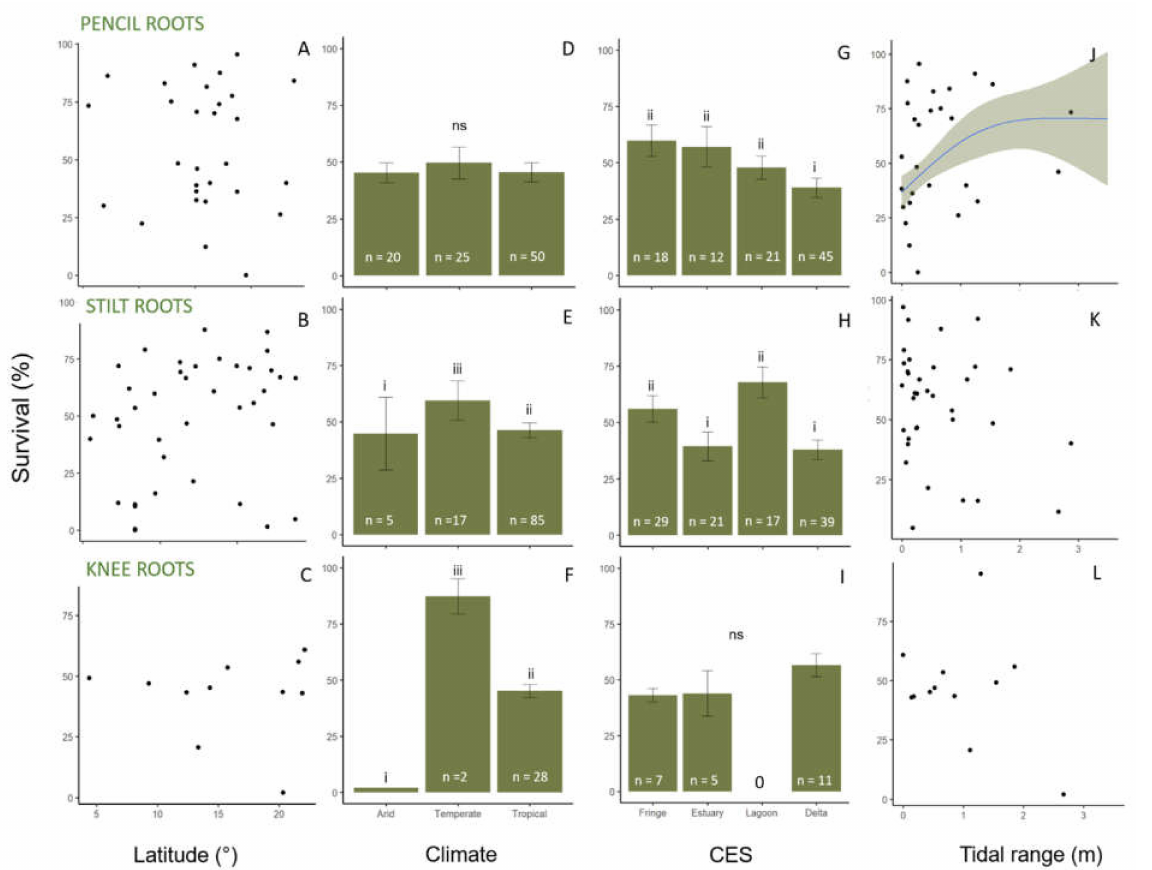
Figure 4. Influence of latitude ( A – C ), climate ( D – F ), coastal environmental setting (CES) ( G – I ) and tidal range ( J – L ) on survival rates for mangrove planting projects involving species that have pencil roots ( A , D , G , J ), stilt roots ( B , E , H , K ) and knee roots ( C , F , I , L ) (see Supplementary Table S1 for species). Data are means ± SE for climate and CES and smooth splines (partial plots) for latitude and tidal range. Different roman numerals signify statistically significant differences among fixed factors, and ‘ns’ = no significant